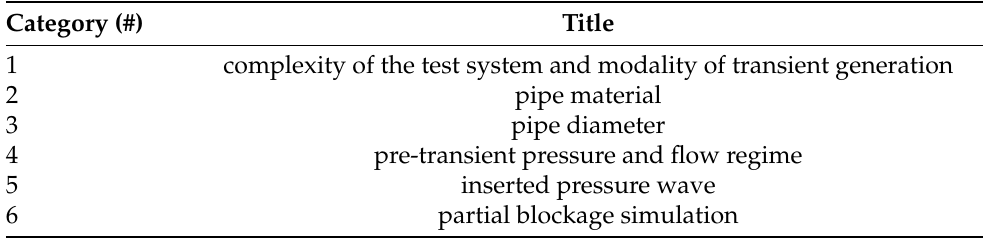
Table 1. Categories identified for the analysis of the physical experimental